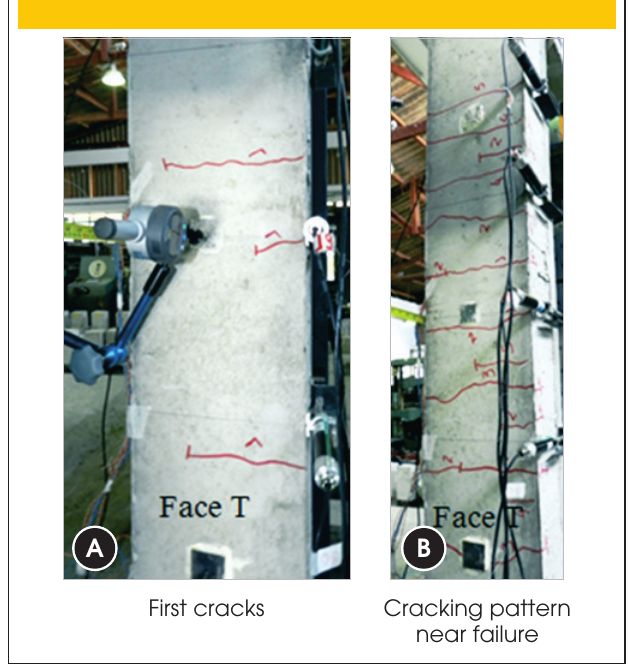
Figure 9 – Cracking patterns in column